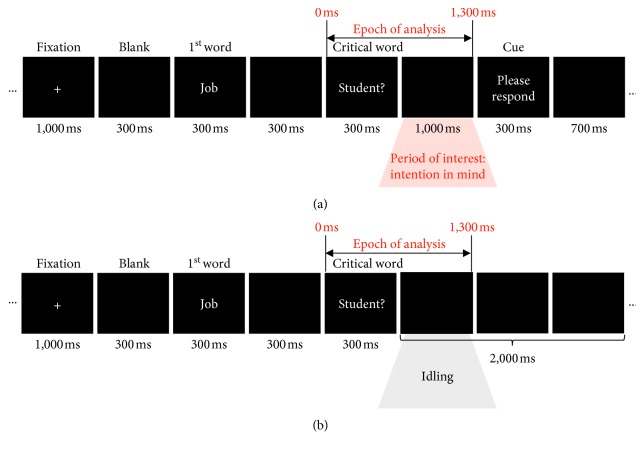
Experimental paradigms for the (a) covert response condition and (b) nonresponse condition.